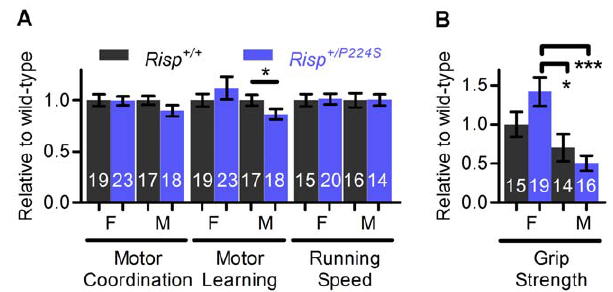
Figure 7. Performance of aged Risp + /P224S mice. The sex of the mice (F for female, M for male), as well as the type of test, are indicated below each bar. ( A ) Various measures of performance in aged, 2-year- old mice, including motor coordination (average of 3 trials after 2 days of training on a Rota-Rod), motor learning (Rota-Rod performance on day 3 relative to day 1), and running speed (the maximum speed mice could maintain on a powered treadmill). Because aged mice were not sacrificed in wild-type/heterozygous littermate pairs, values were normalized to a wild-type value of 1. ( B ) Grip strength (duration for which mice are capable of hanging suspended below a metal grid) for aged mice. Values were normalized to female wild-type. ‘*’ denotes p=0.01 to 0.05 and ‘***’ denotes p , 0.001 verses wild-type controls. Sample sizes are shown superimposed on each bar. Actual (non- normalized) values for (A) and (B) are shown in Table